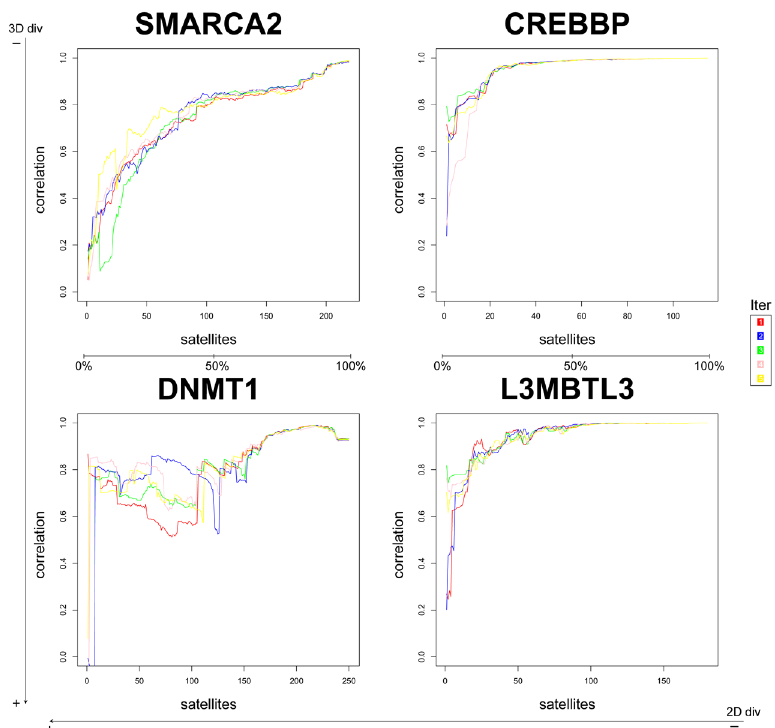
Figure 1. Backwards analysis with 2PCs picking satellites by diversity. The correlation with the results from the whole matrix was calculated with increasing numbers of satellites. Each colored line represents one of the five iterations.